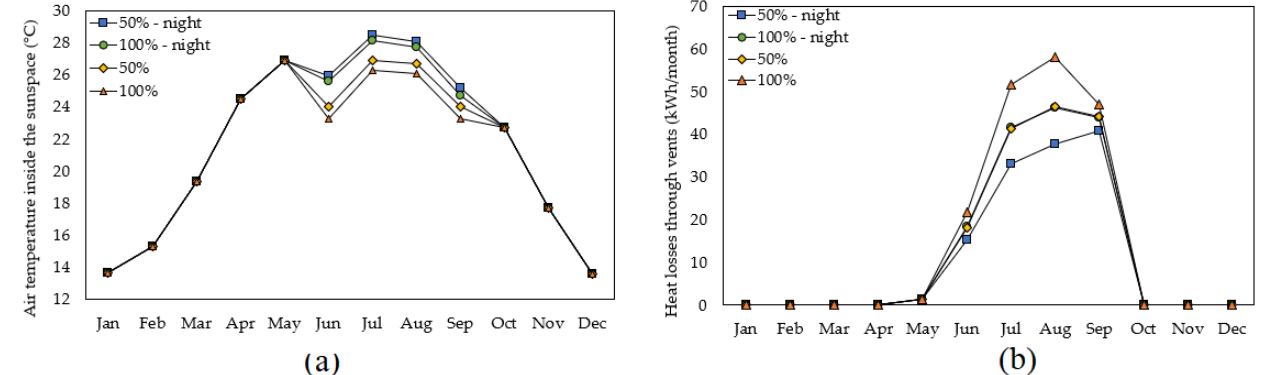
Figure 10. Ventilation analysis: ( a ) Monthly average air temperature inside the sunspace; ( b ) monthly average living room heat losses through vents.